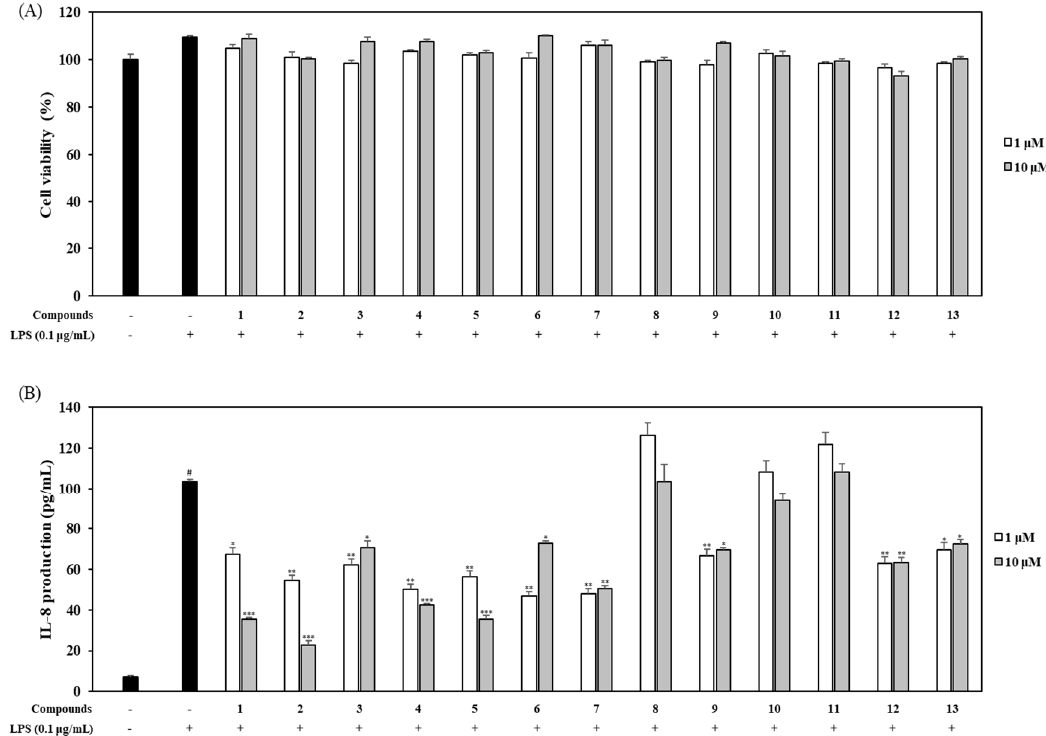
Figure 6. E ff ects of limonoids on the LPS-induced expression of IL-8 in HT-29 cells. HT-29 cells were treated with compounds 1 – 13 (1 and 10 µ M) for 2 h and stimulated with 100 ng / mL LPS for 18 h. The viability of cells was then determined using an MTT assay ( A ) and the level of IL-8 in the culture media was measured with an ELISA kit ( B ). The values are expressed as mean ± standard deviation of three individual experiments. # p < 0.01, compared to the control group; * p < 0.05, ** p < 0.01, *** p < 0.001, compared to the LPS-treated group.